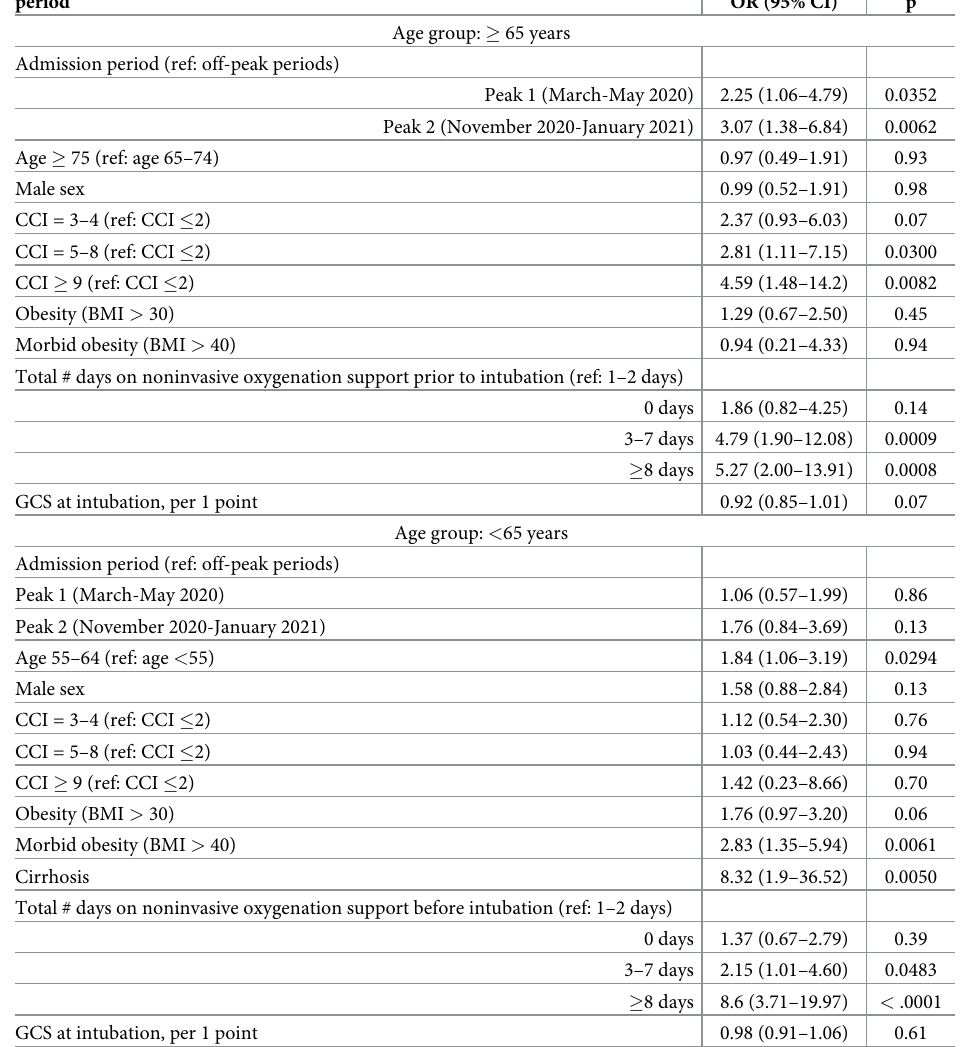
Table 3. Independent predictors of inpatient mortality in COVID-19 patients on mechanical ventilation by age group.